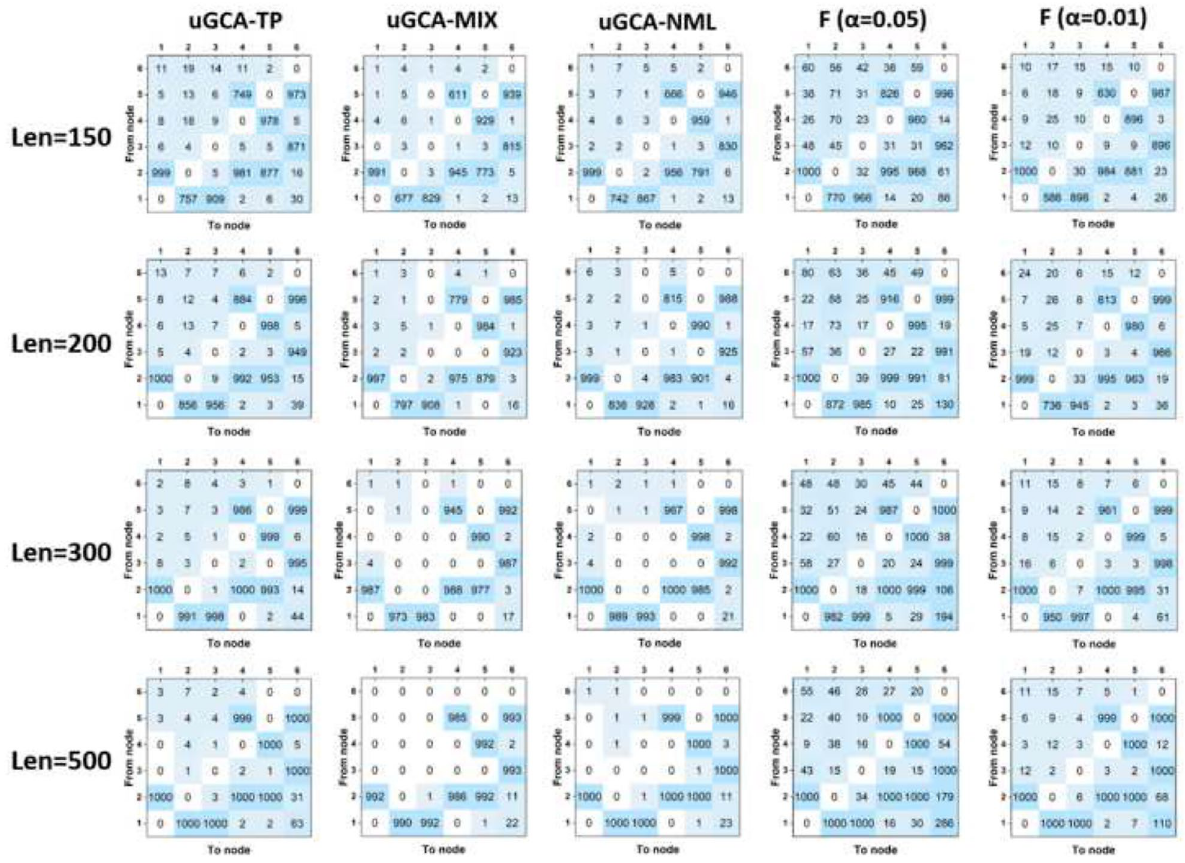
Fig. 3 Causal connectivities obtained by uGCA and conventional GCA under different data length. From top row to bottom row, the data length is 150, 200, 300,